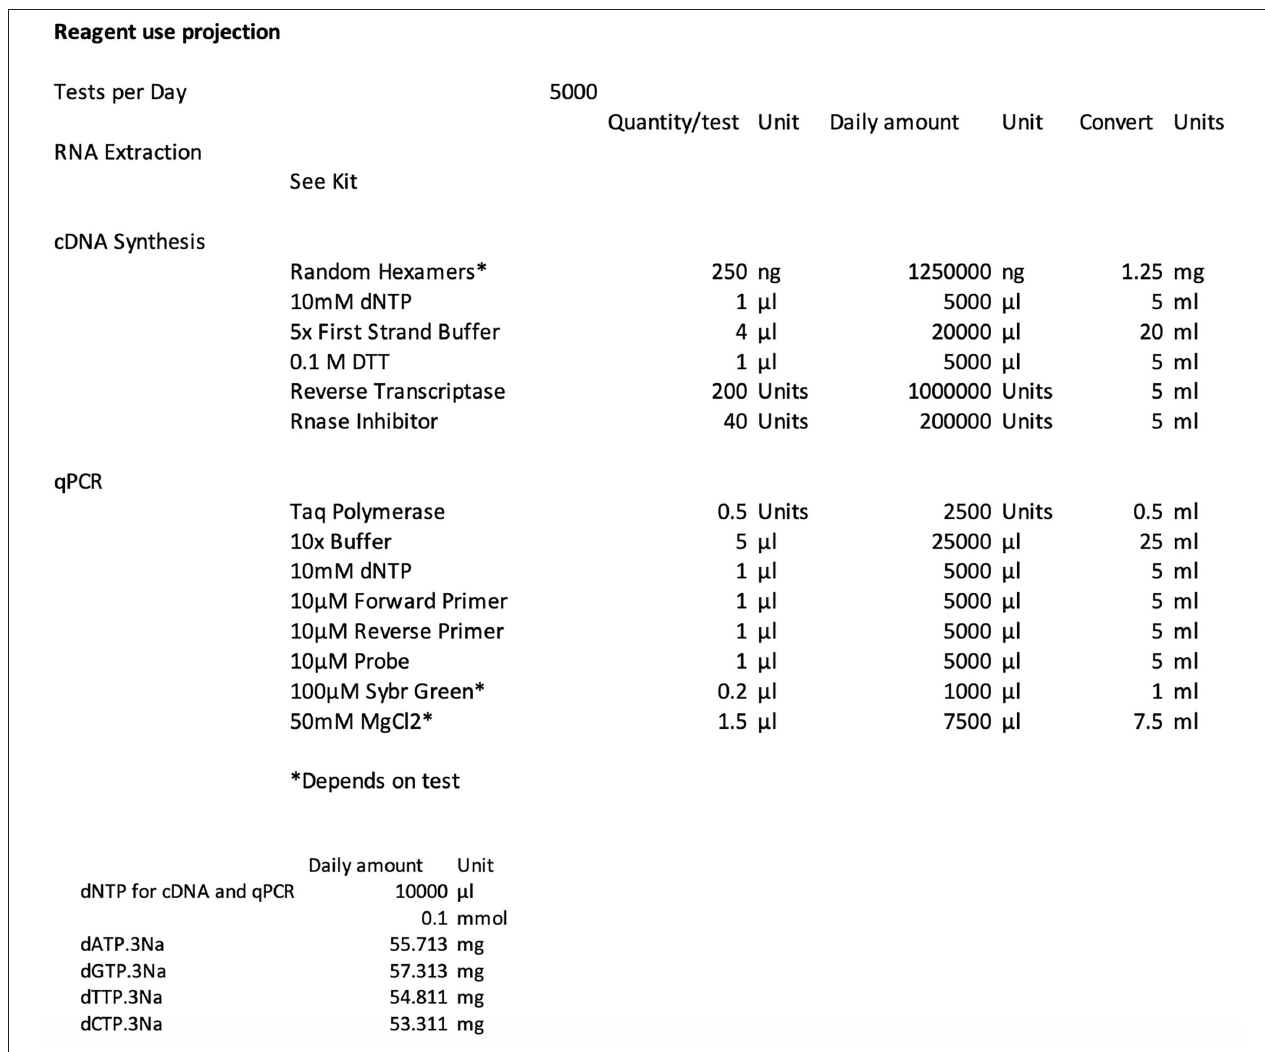
FIGURE 1 | Interactive reagent calculator used to determine what, and in what quantity, reagents were required for a successful onshore production scheme. Not all components used in this reagent calculator contributed to the final HB RT-qPCR